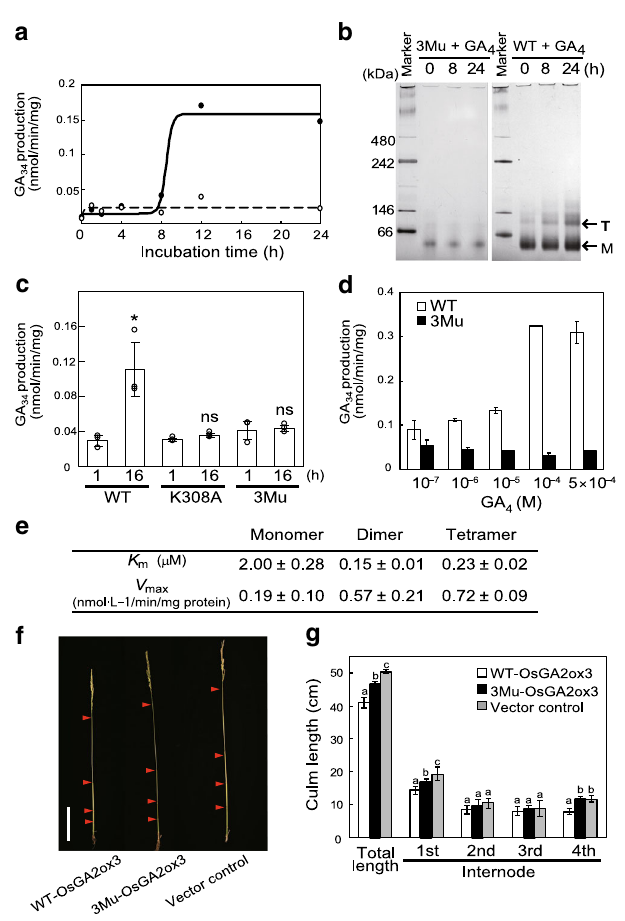
Fig. 2 Multimerization of OsGA2ox3 enhances its activity in vitro and in planta. a Time course of OsGA2ox3 activation by GA 4 . The activity of WT- and 3Mu-OsGA2ox3 is shown by closed and open circles, respectively. b Assessment of OsGA2ox3 multimerization by blue-native PAGE. WT- and 3Mu-OsGA2ox3 are indicated with GA 4 for 0, 8, and 24 h. Monomer (M) and tetramer (T) are indicated. c Enzyme analyses of OsGA2ox3, 3Mu, and K308A mutant ( n = 3 biologically independent samples; central values and error bars represent means ± s.d.). The differences within the same category are indicated. * P < 0.05; NS not signi fi cant ( P > 0.05); two-tailed paired t -tests. d Dose response of OsGA2ox3 and 3Mu activation by GA 4 ( n = 3 biologically independent samples; central values and error bars represent means± s.d.). OsGA2ox3 (white bars) and 3Mu (black bars) were incubated for 12 h at various GA 4 concentrations. e K m and V max of OsGA2ox3 with different multimerization forms ( n = 3 biologically independent samples). f Representative internode elongation pattern shown in g . Red arrowheads indicate the position of nodes. Scale bar = 10 cm. g Complementation of the culm elongation in ga2ox3 knockout plants by overexpression of WT- and 3Mu- OsGA2ox3 cDNA ( n = 6 biologically independent samples; central values and error bars represent means ± s.d.). Different letters denote signi fi cant differences ( P < 0.05) based on the Tukey – Kramer